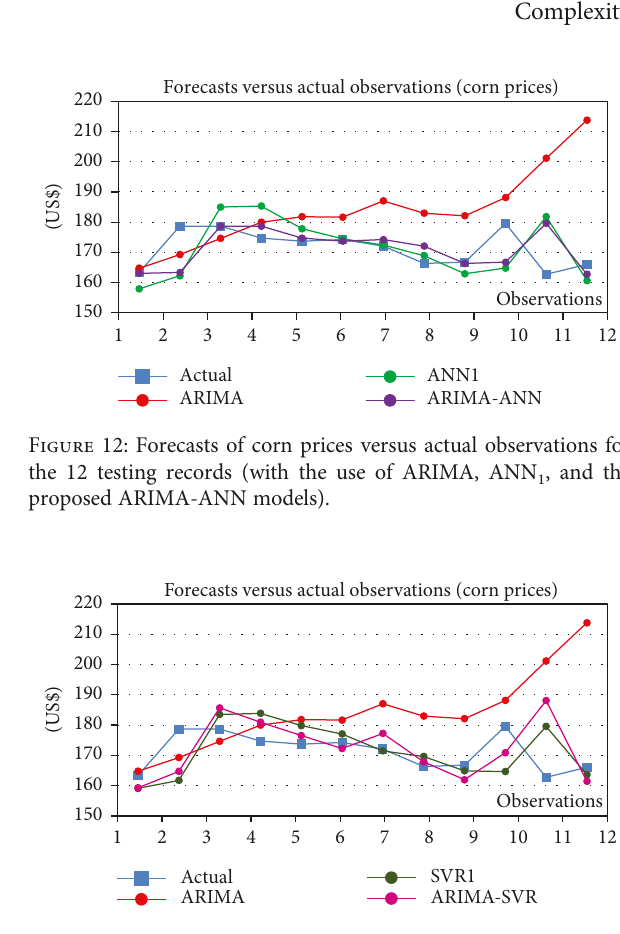
Figure 10: Forecasts of wheat prices versus actual observations for the 12 testing records (with the use of ARIMA, SVR proposed ARIMA-SVR models).